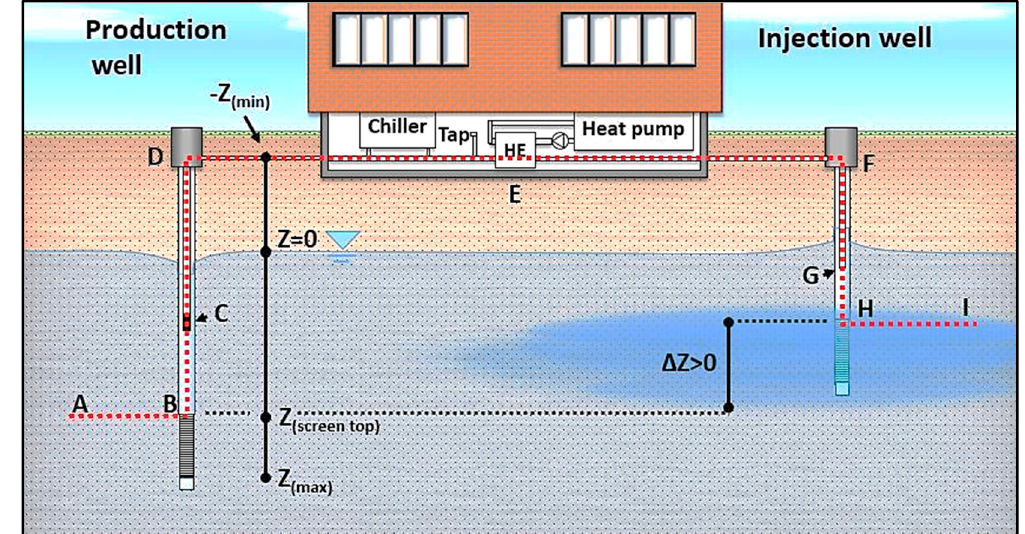
Figure 5. Traditional Norwegian GWHP design methodology can typically result in this system configuration. Different key components (A–I) are installed at various depths ( z ) in relation to the water level of the aquifer, Z water table = 0 m.